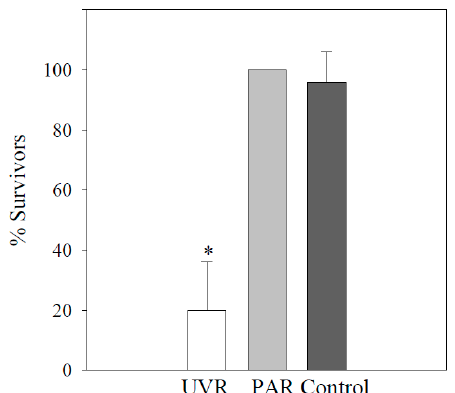
Figure 2. Surviving individuals (% ± std) of Stokesia vernalis after 48 h after exp 3 (follow-up on exp 2): n = 4 replicate wells containing five individuals each; * indicates a significant difference between the UV treatment and the control ( p < 0.05). Table 1. Concentrations of mycosporine-like amino acids (10 − 5 µg µg − 1 ciliate dry weight) in individuals of Stokesia vernalis ( n = 14–16) and Pelagodileptus trachelioides ( n = 48–54) collected after exposure to UVR and PAR and in the control (exp 1). Traces: concentrations <1% of the total. Percentages in brackets = % of the concentration of a specific mycosporine-like amino acid (MAA) in the total concentration of MAAs detected.